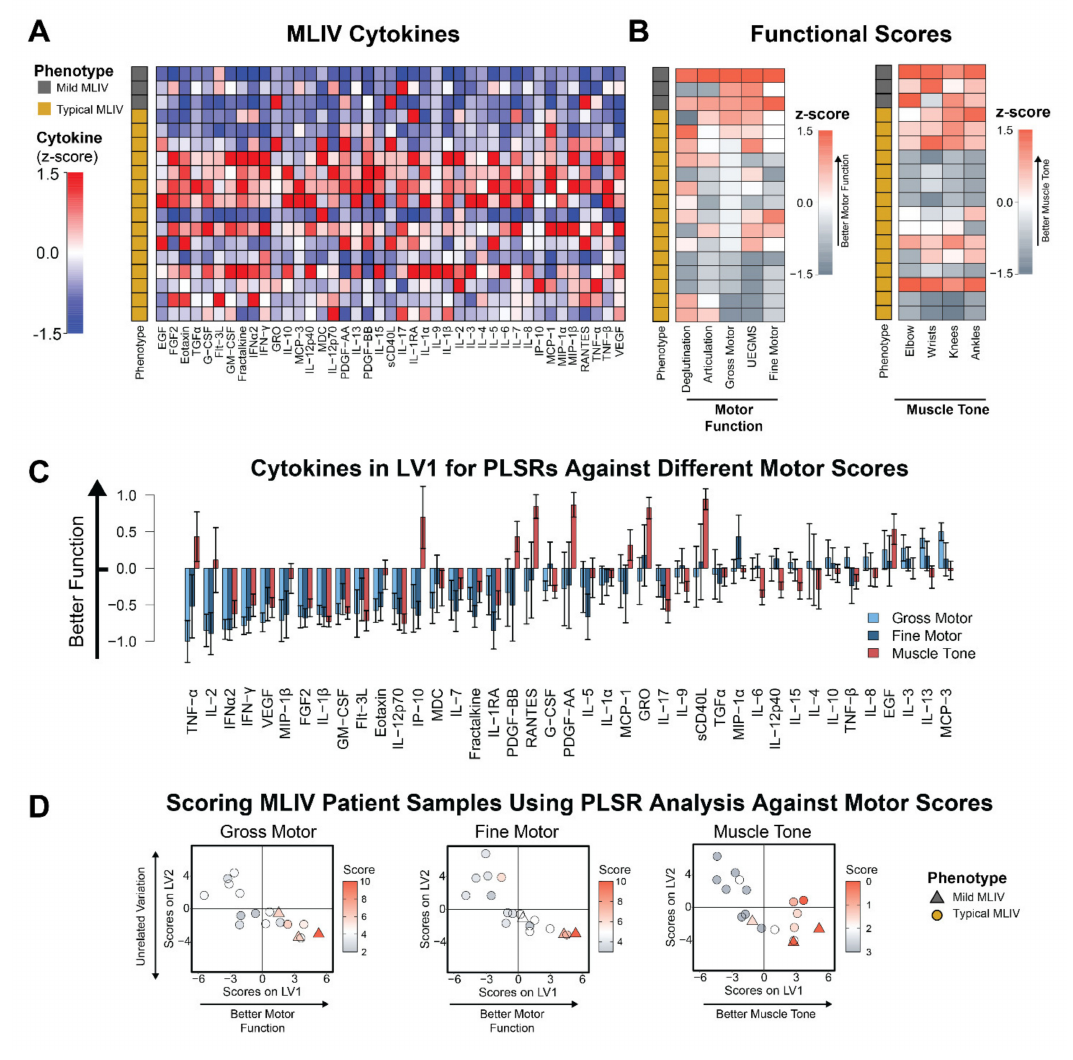
Figure 2. Blood cytokine signatures are related to motor dysfunction in MLIV patients. ( A ) Heatmap of relative cytokine expression for MLIV samples (columns are z-scored). N = 18 MLIV (15 typical and 3 mild). ( B ) Brief Assessment of Motor Function (BAMF) and Modified Ashworth scores for all MLIV patients (z-scored). Rows are sorted to match cytokine samples in panel A. ( C ) PLSR regressions of MLIV patient cytokines against gross motor, fine motor, and muscle tone (elbow) reveal profiles of cytokines (LV1) that correlate with poorer function (negative) or better function (positive) (mean ± SD in a LKOCV with K = 3). ( D ) Scoring each MLIV patient sample based on the overall cytokine expression profile for each sample and each regression separated samples with poorer function to the left and better function to the right along LV1. The second axis, LV2, was associated with unrelated variation. Mild cases are shown as triangles and typical cases are shown as